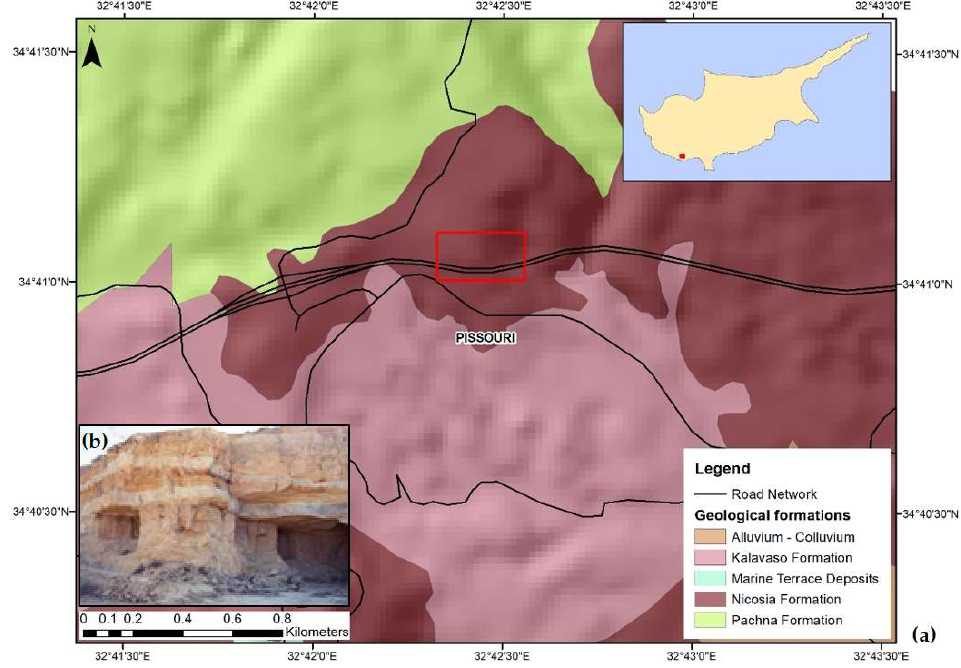
Figure 2. ( a ) The geological map and location of the study area [29] (Data provided by the Geological Survey Department). The wider area where the landslide occurred (marked in red) lies on ( b ) the Nicosia Formation [47].